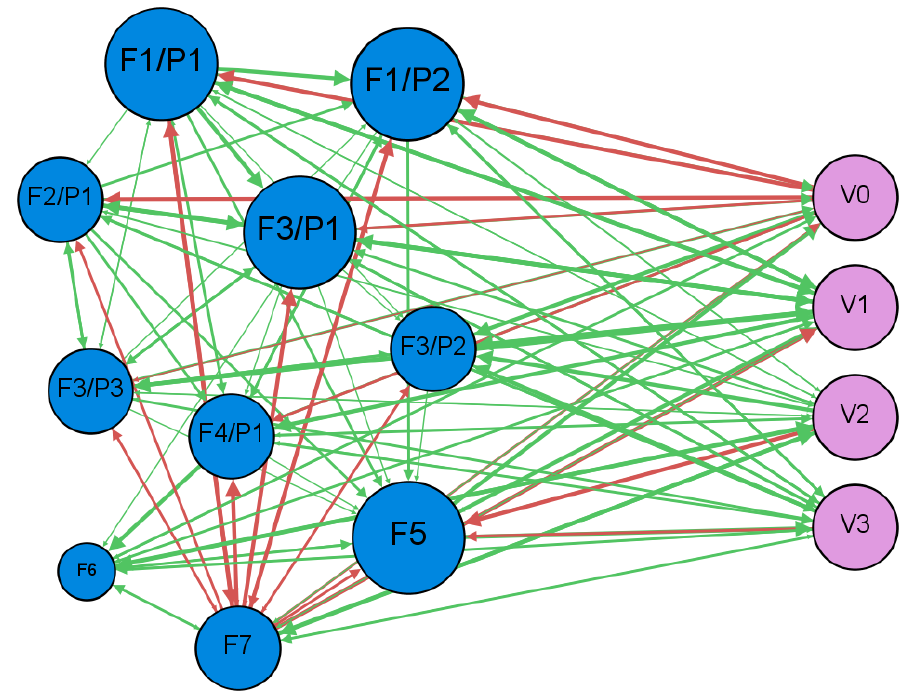
Figure 10. Positive and negative relations that occur between the analysed criteria and decision alternatives according to the assessment of the first expert. Energies 2020 , 13 , x FOR PEER REVIEW